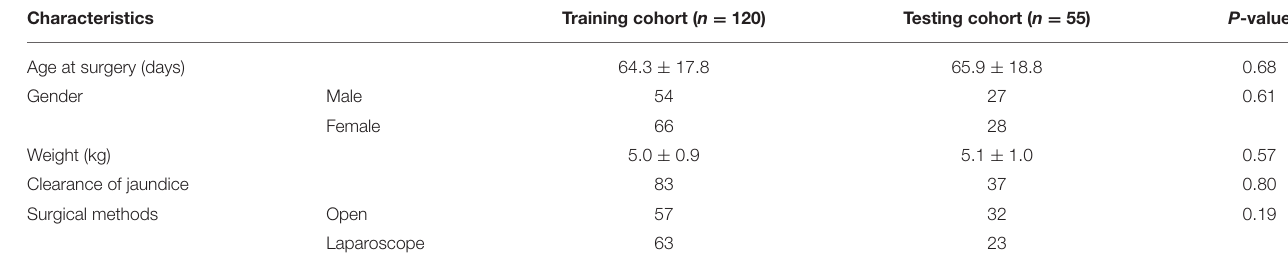
TABLE 1 | The baseline characteristics of patients in training and testing cohorts.